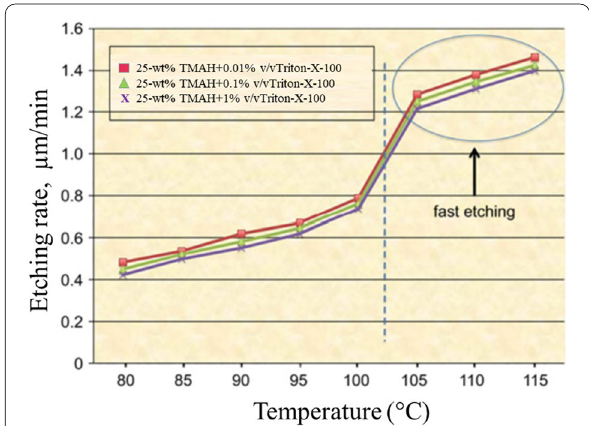
Fig. 20 Etch rate of Si{100} as a function of etching temperature in 25 wt% TMAH with a surfactant Triton-X-100 in a volume fraction of 0.01–1% [69], © 2014,